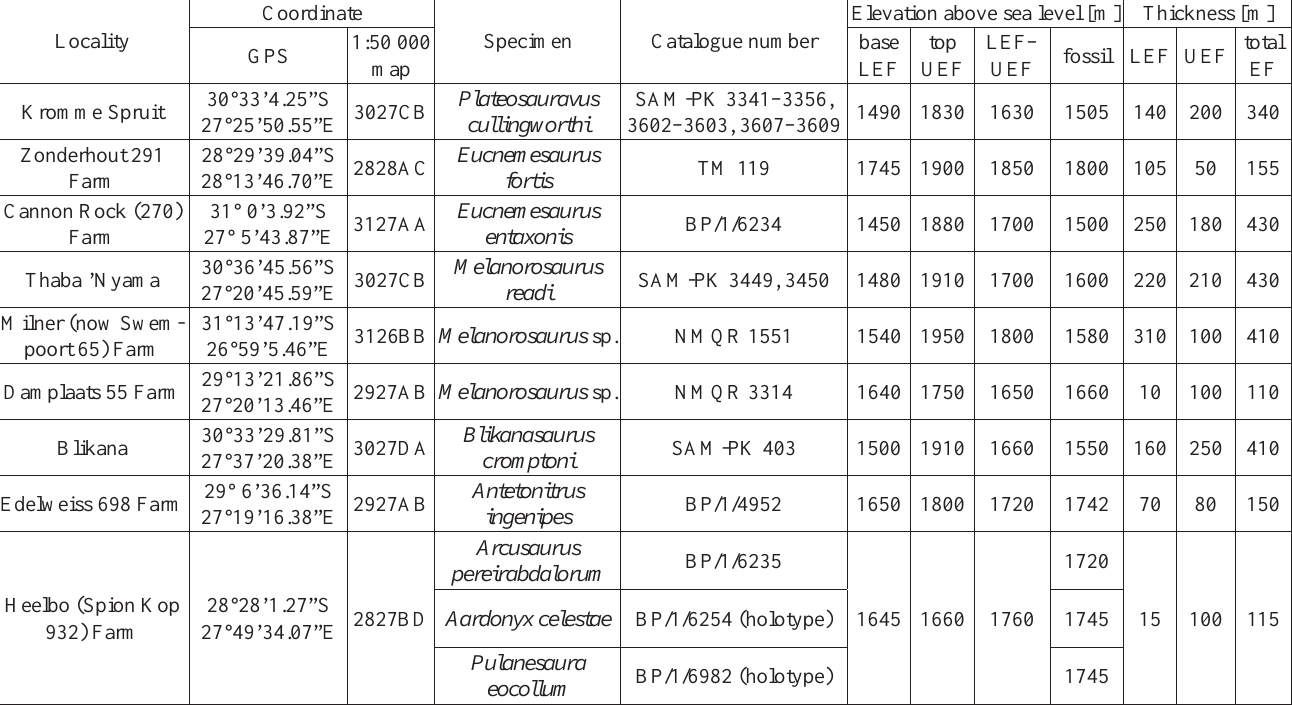
Table 1. Stratigraphic and geographic information of key sauropodomorph fossil localities within the Upper Triassic to Lower Jurassic Elliot Formation of South Africa. See text for